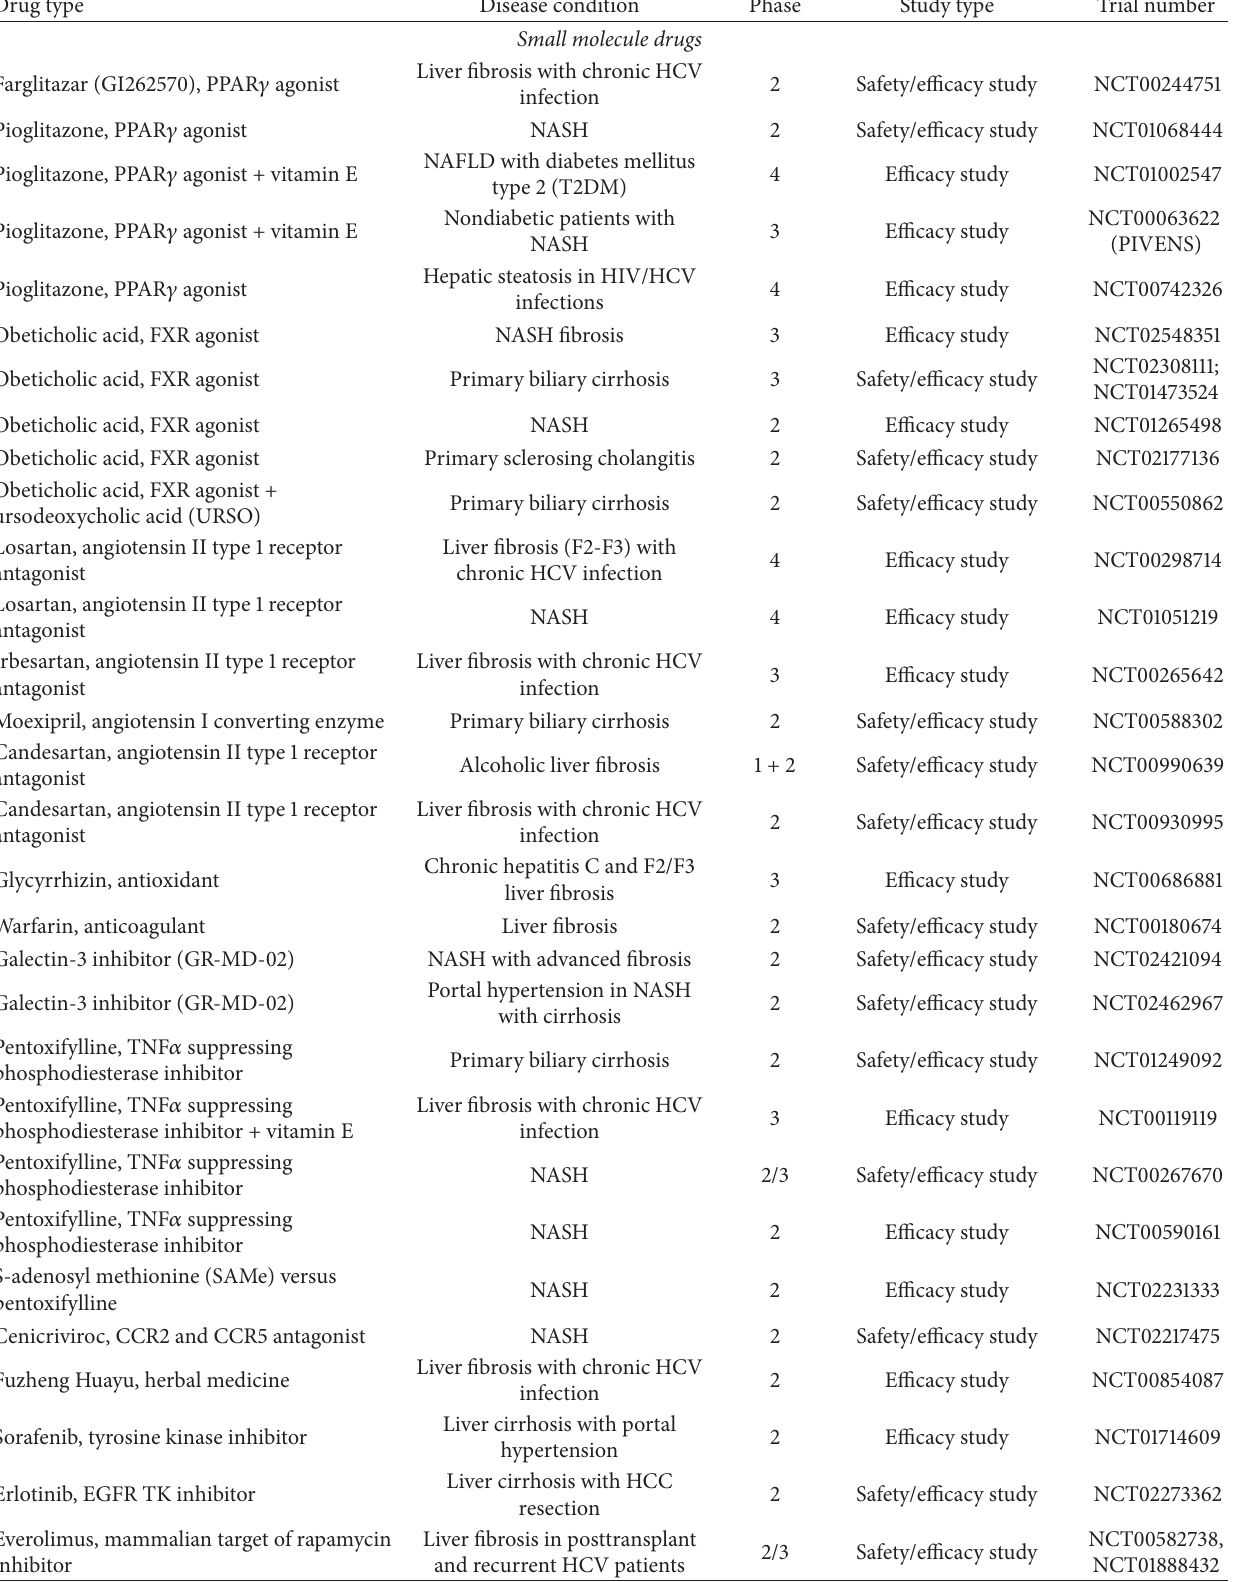
Table 1: Summary of the registered clinical trials